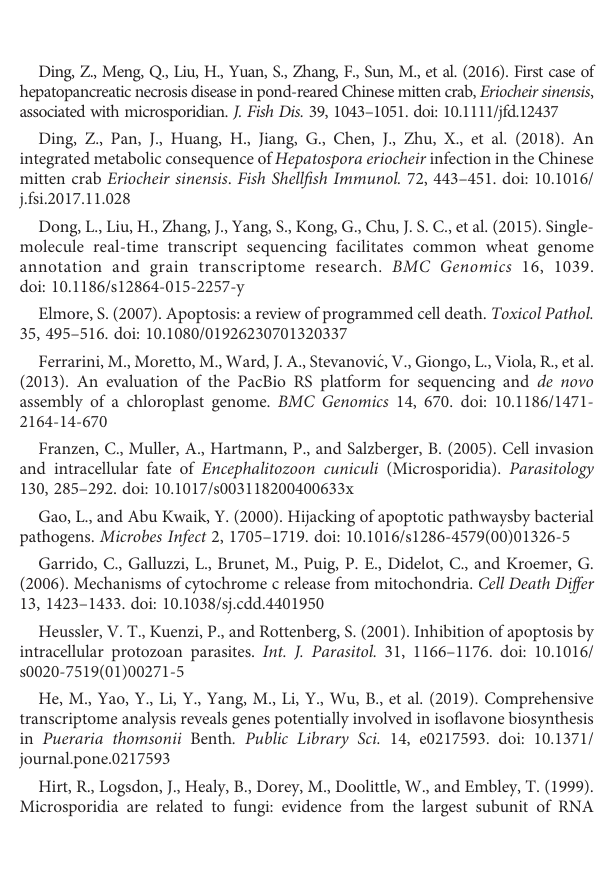
SUPPLEMENTARY FIGURE 1 MA plot (M-versus-A plot) and volcano plot for the FL transcripts. SUPPLEMENTARY TABLE 1 The characteristics of unigenes from the full-length transcriptome. SUPPLEMENTARY TABLE 2 The KEGG classi fi cation of all unigenes.